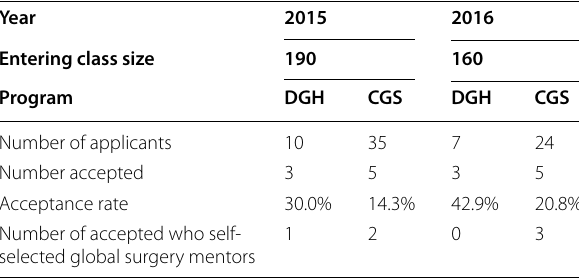
Table 2 Applicants, acceptances and self-selected global surgery students to the Distinction in Global Health (DGH)